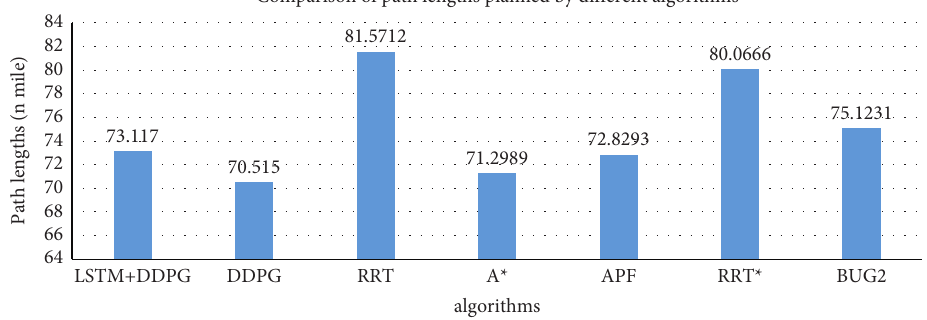
Figure 13: Path lengths planned by different